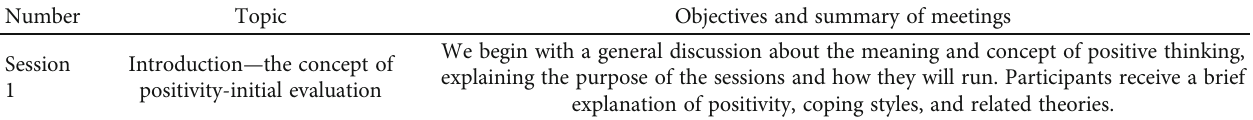
Table 1: Summary of positive psychotherapy.